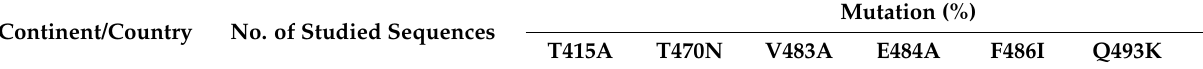
Table 5. Continent/country-wise prevalence of prolonged infections’ mutations in the receptor-binding domain of the SARS-CoV-2 spike protein from 30 May 2021 till 28 July 2021.